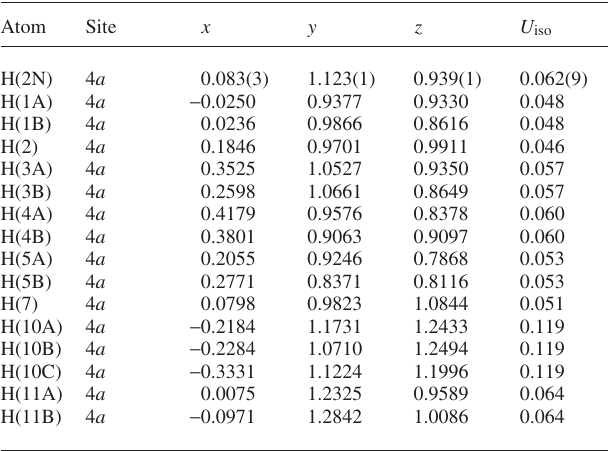
Table 2. Atomic coordinates and displacement parameters (in Å 2 )